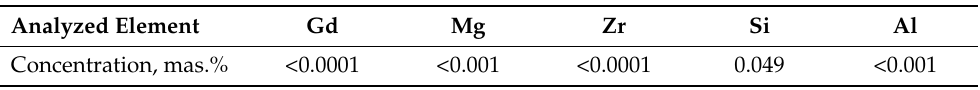
Table 4. Chemical analysis of the LiCl-4 mas.% Li 2 O melt after 48 h holding the samples.